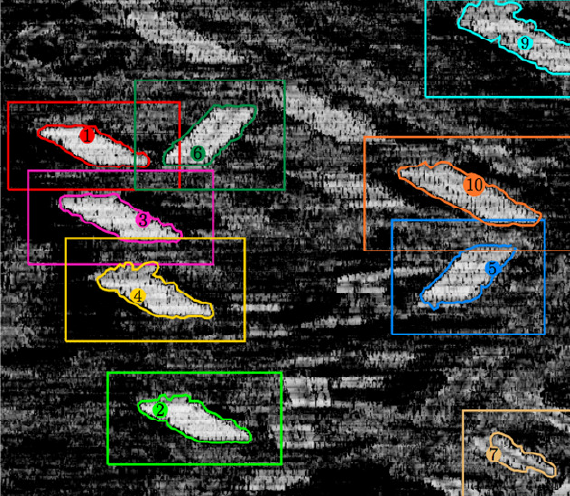
Figure 6: Building patches: detector image overlaid with segmented layover regions and corresponding patch areas